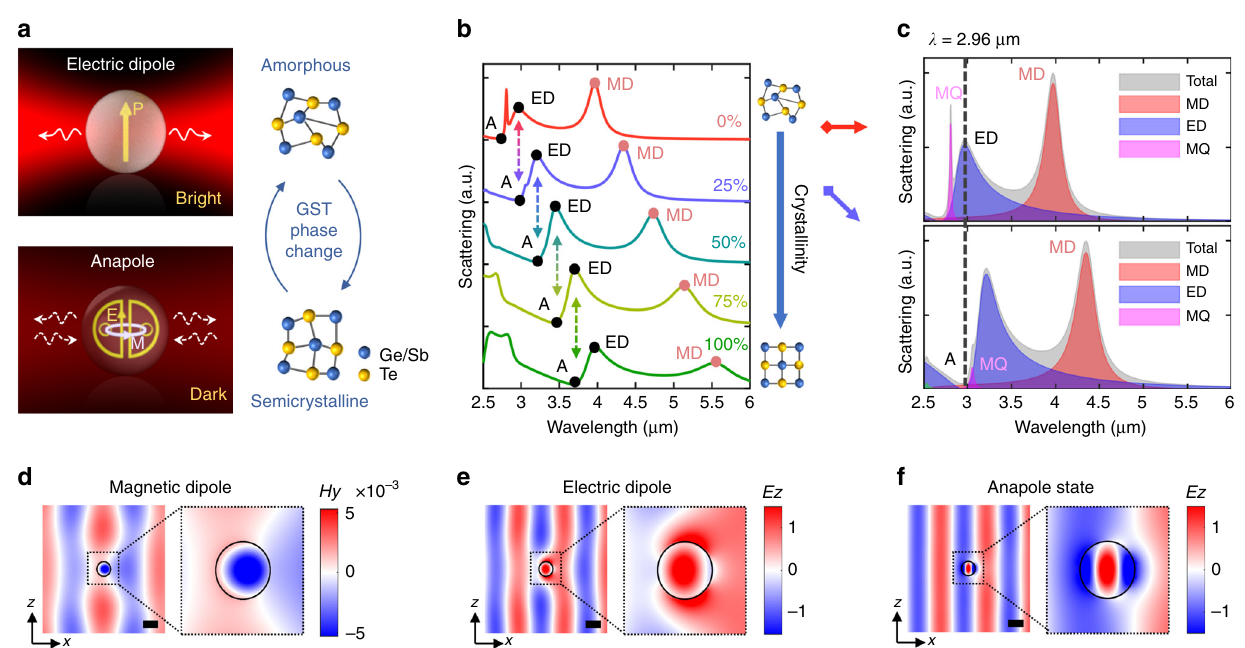
Fig. 1 Shifting between scattering bright and dark states in a GST sphere. a Conceptual illustration of an electric dipole resonance and an anapole excitation in a GST sphere. Shifting between these two states can be realized by introducing an intermediate phase transition in the GST material. b Normalized scattering spectra of a GST sphere ( R = 450 nm) with different crystallinities. A continuous shifting between ED and anapole states (denoted as A) can be clearly observed. c Analytical multipole analysis of two representative scattering spectra of amorphous GST (aGST) and 25%-crystalline GST (25%-cGST) spheres. d , e Magnetic and electric fi eld distributions of the aGST sphere excited at the two scattering bright states, i.e., MD ( λ = 3.95 μ m) and ED ( λ